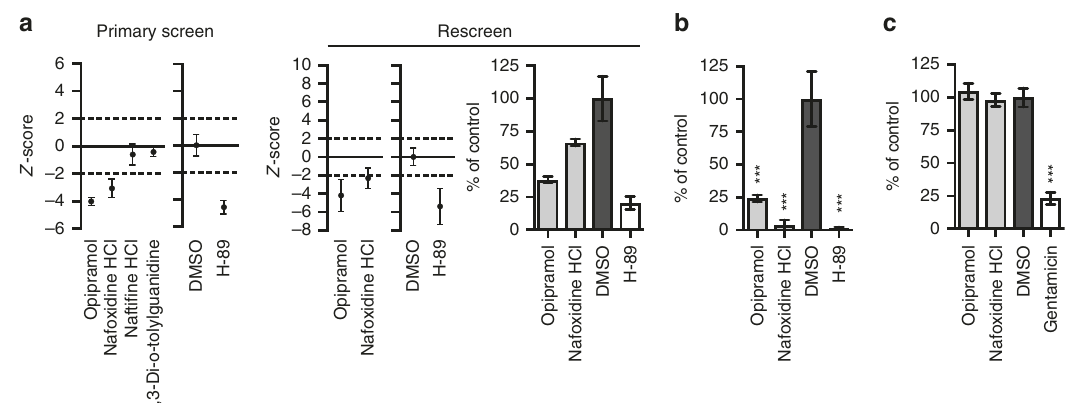
Fig. 5 Screen of in silico-predicted chemical compounds active against intracellular Stm . a Chemical compound primary screen (left panel) and rescreen (middle panel) at 10 µ M in the HeLa- Stm infection model using Stm constitutively expressing stable DsRed, expressed as mean z -scores ± standard deviation. Horizontal dashed lines indicate a hit cutoff at a z -score of 2 or − 2. The average z -scores and standard deviations of the controls (DMSO and H- 89) are displayed separately. To indicate the extent of bacterial inhibition, rescreen results are expressed as a percentage of control value ± standard deviation in the right panel. b CFU assay of the HeLa- Stm infection model treated with the validated hit compounds from a at 10 µ M. Representative data out of three independent experiments, displayed as a percentage of the DMSO control are shown. The average ± standard deviation of three replicates is shown. Statistically signi fi cant differences compared to DMSO were tested using a one-way ANOVA (F (3,8) = 56.31; *** p value < 0.001). c Overnight treatment of Stm broth cultures with the hit compounds at 10 µ M. The Stm antibiotic gentamicin (50 μ g/ml) was used as a positive control. The average bacterial density ± standard deviation of three replicates is shown, expressed as a percentage of the DMSO control. Representative results out of three individual experiments are displayed. Statistically signi fi cant differences compared to DMSO were tested using a one-way ANOVA (F (3,38) = 579.5; *** p value <